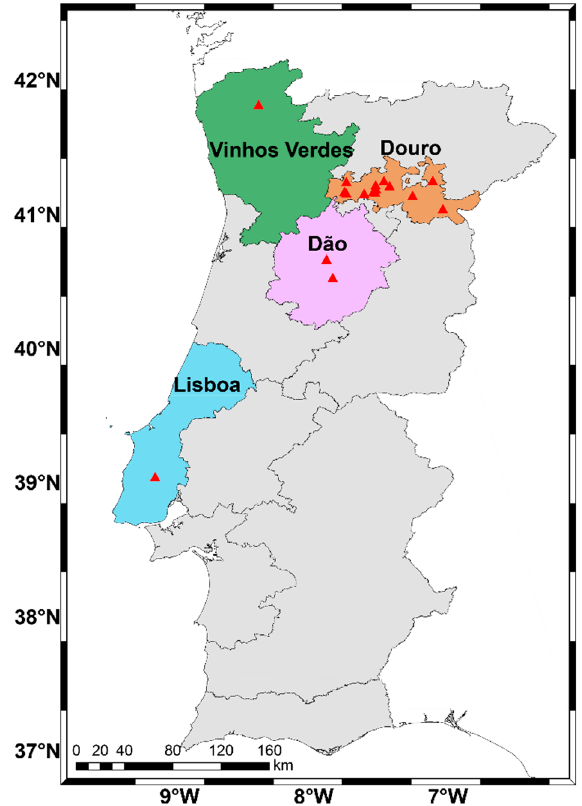
Figure 1. Map of mainland Portugal with the four targeted wine regions (Douro, Dão, Vinhos Verdes, and Lisboa) and vineyard plot/weather station locations (red triangles). Table 1. Description of the selected phenological data for the three main phenological stages 145 (budburst, flowering, and veraison) by wine region (Douro, Dão, Vinhos Verdes, and Lisboa) and for 146 the selected varieties. The geographical location (latitude and longitude) of each pair wine 147 region/vineyard plot are indicated. The same locations apply to their corresponding weather stations. 148 The grapevine varieties and the corresponding periods of phenological data are also outlined. 149